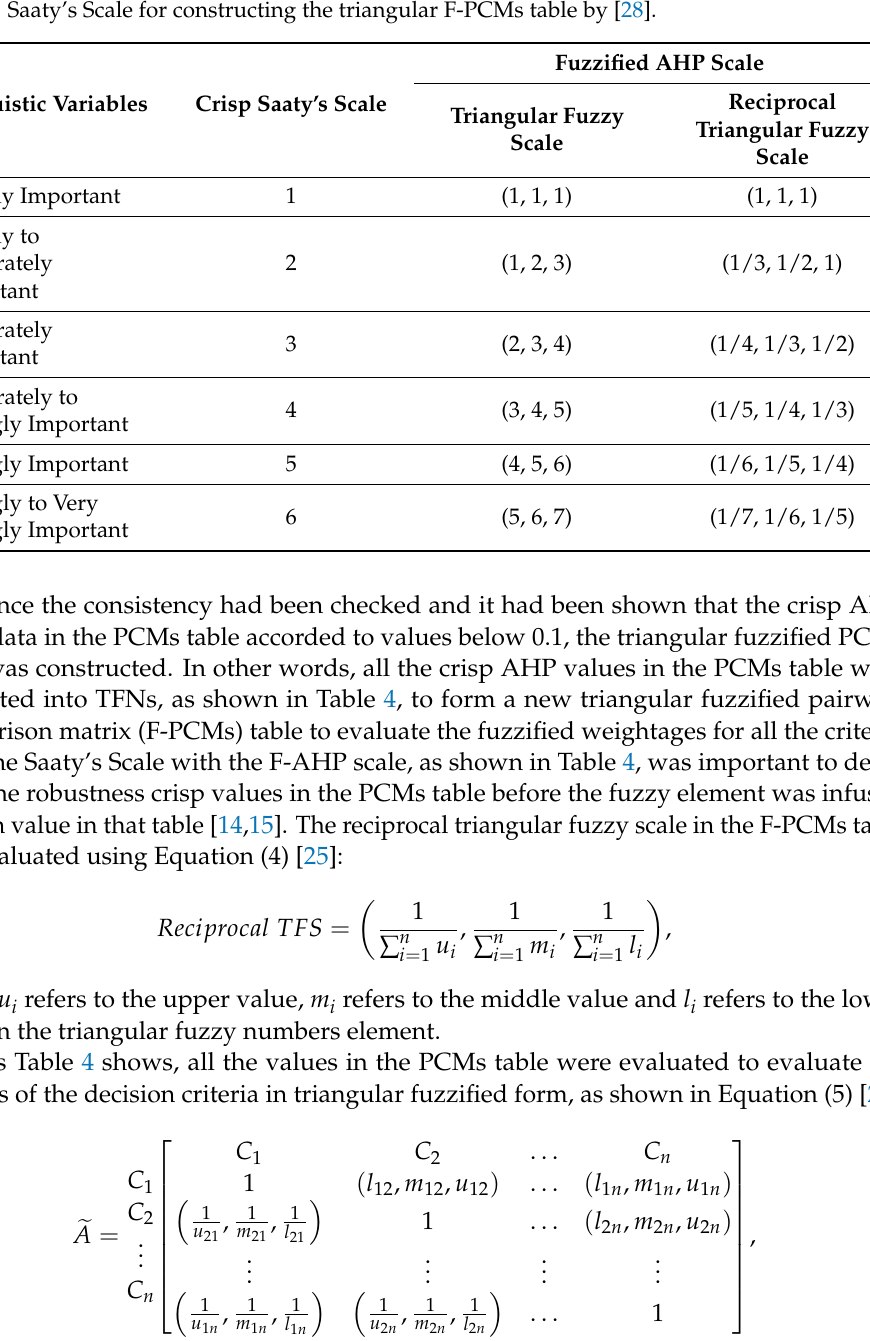
Fuzzified AHP Scale Reciprocal Triangular Fuzzy Triangular Fuzzy Scale